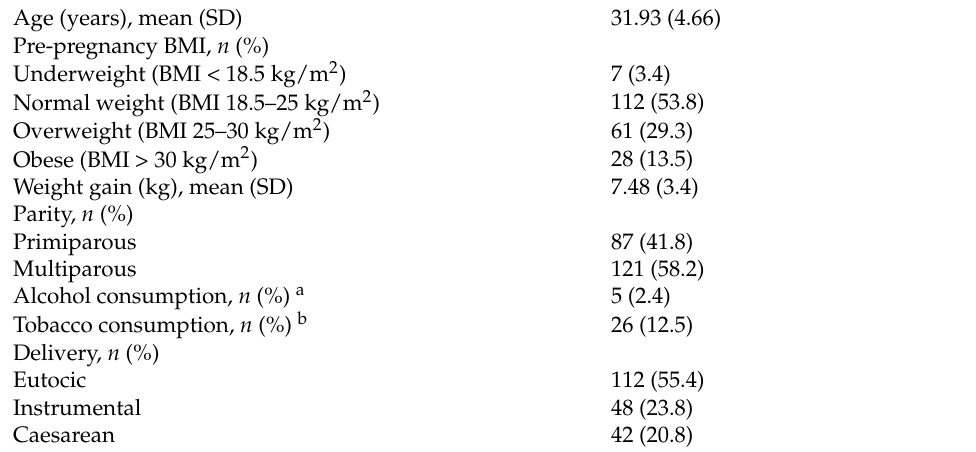
Table 1. General characteristics of pregnant women ( n = 208).